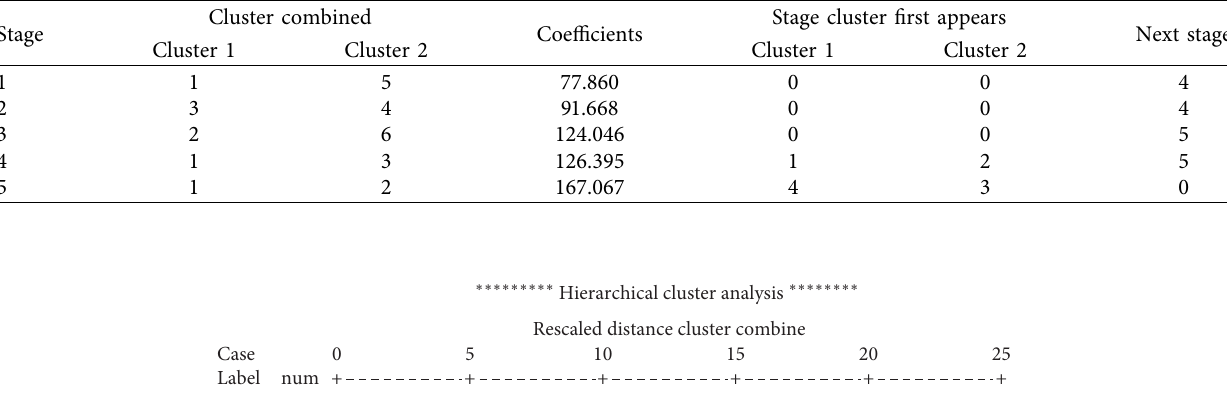
Table 3: Agglomeration schedule.